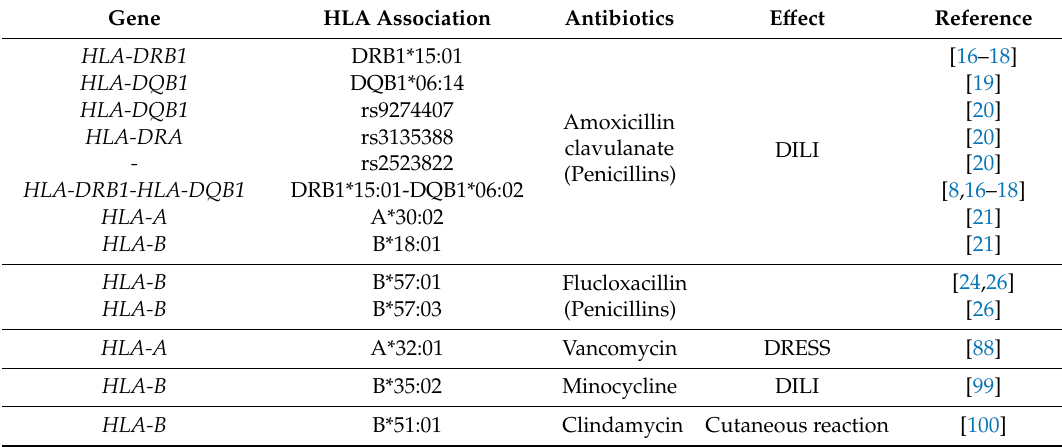
DILI: drug induced liver injury; DRESS: drug reaction with eosinophilia and systemic